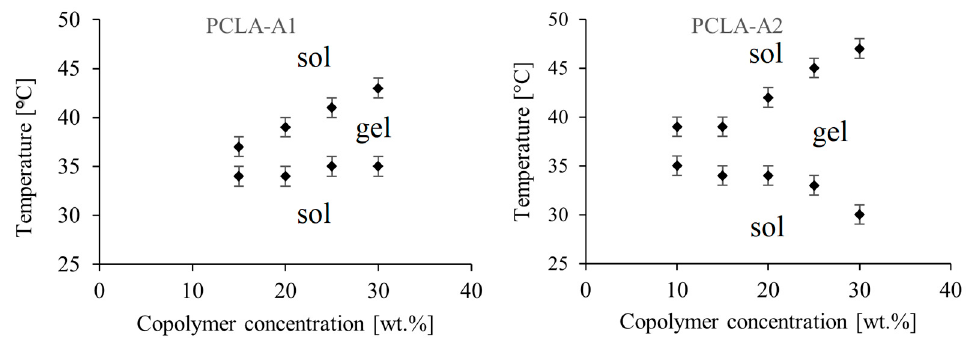
Figure 5. Phase transition diagrams of the PCLA hydrogels (PCLA-A1 and PCLA-A2).